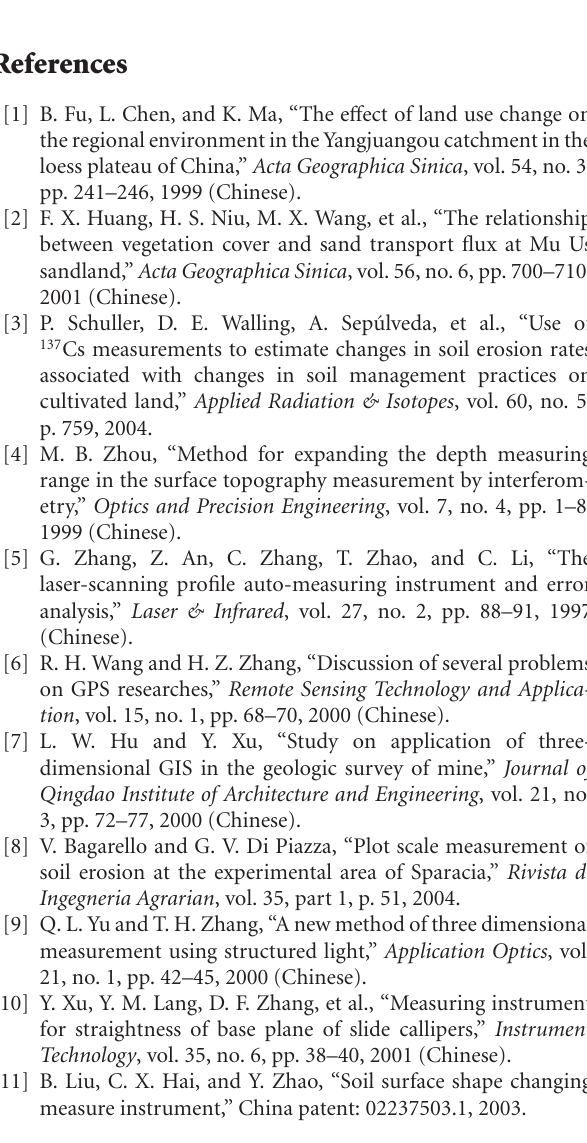
Figure 5: The measured wind erosion depth versus the measure- ment